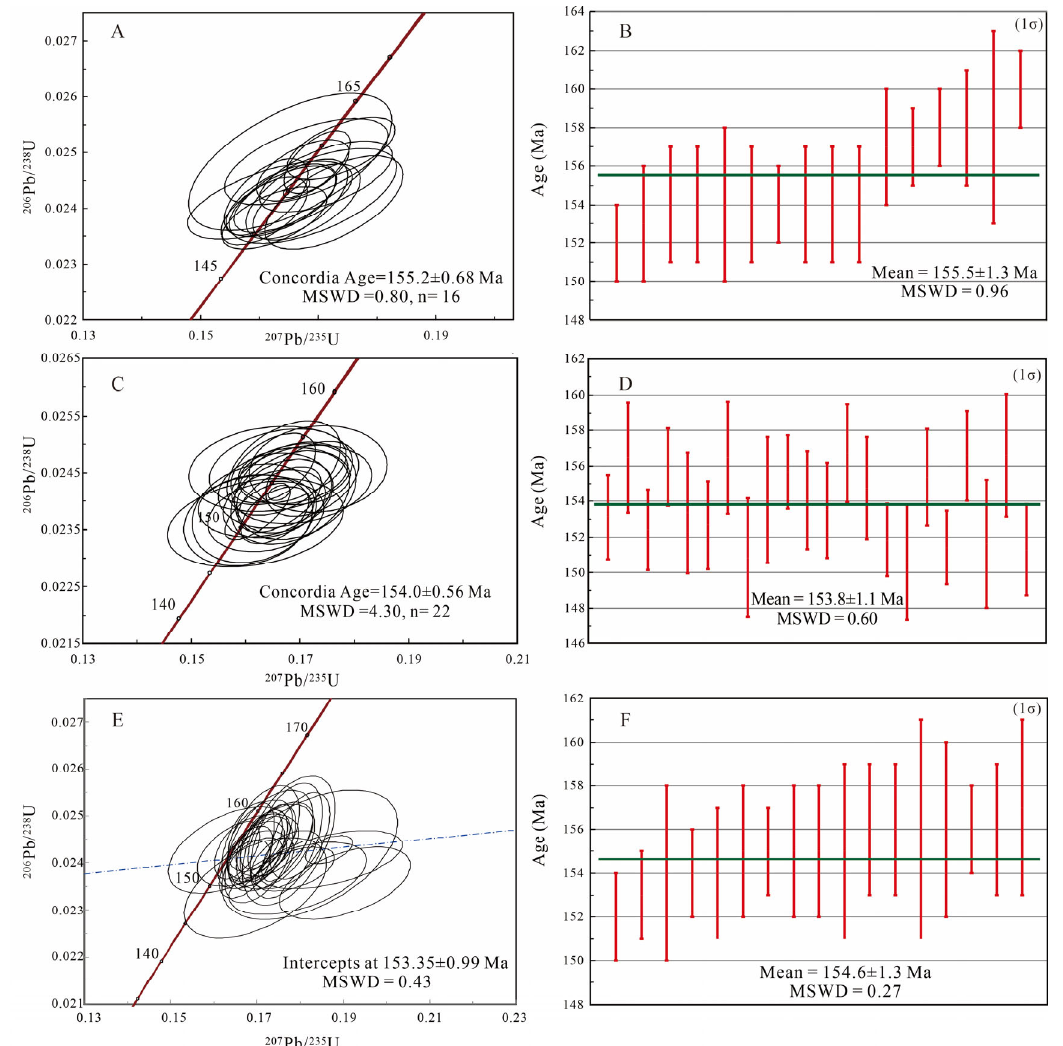
Figure 8. LA ‐ ICP ‐ MS U–Pb concordia diagrams and weighted mean 206 Pb/ 238 U ages of zircon in the Figure 8. LA-ICP-MS U–Pb concordia diagrams and weighted mean 206 Pb/ 238 U ages of zircon in Jinzhuping medium to coarse ‐ grained biotite granite ( A and B ), porphyritic biotite granite ( C and the Jinzhuping medium to coarse-grained biotite granite ( A , B ), porphyritic biotite granite ( C , D ) and D ) and aplite ( E and F ). aplite ( E , F